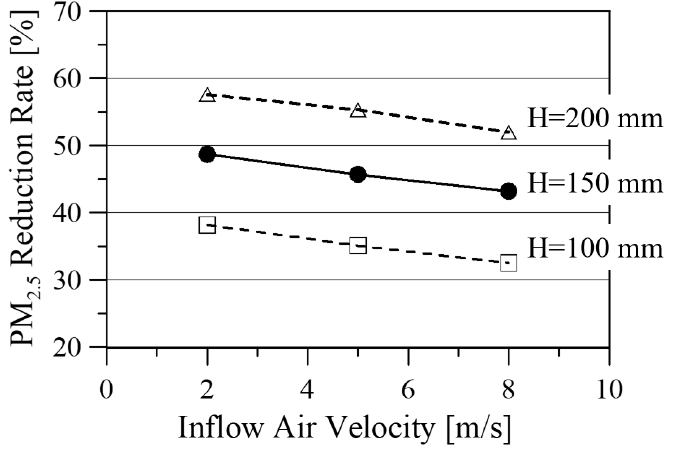
Figure 10. PM 2.5 reduction rate with respect to inflow air velocity and soil moisture of 15 ± 5%. Table 4. Average value of PM 2.5 reduction rate for the soil height and the inflow air velocity.